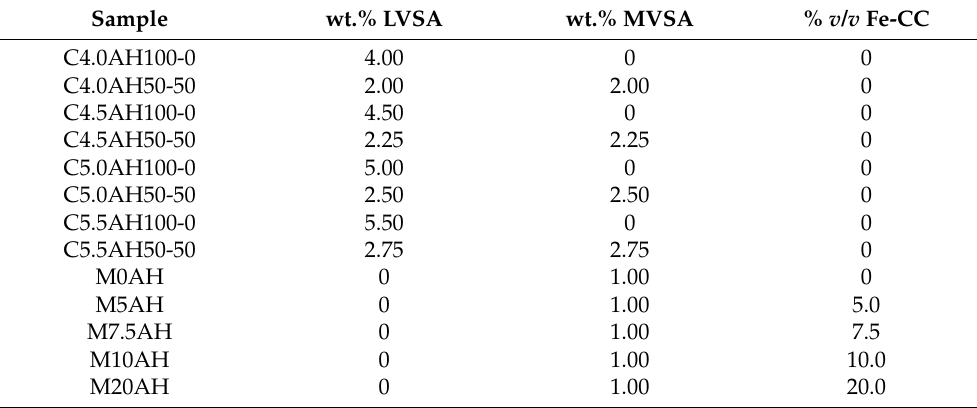
Table 3. Concentrations of LVSA, MVSA and Fe-CC in all the synthesized nonmagnetic and magnetic hydrogels. CXAH100-0 and CXAH50-50 are the control samples where X is the total alginate concen- tration. MYAH are the hydrogels for the actuator where Y is the concentration of magnetic particles. Sample wt.% LVSA wt.% MVSA % v / v Fe-CC C4.0AH100-0